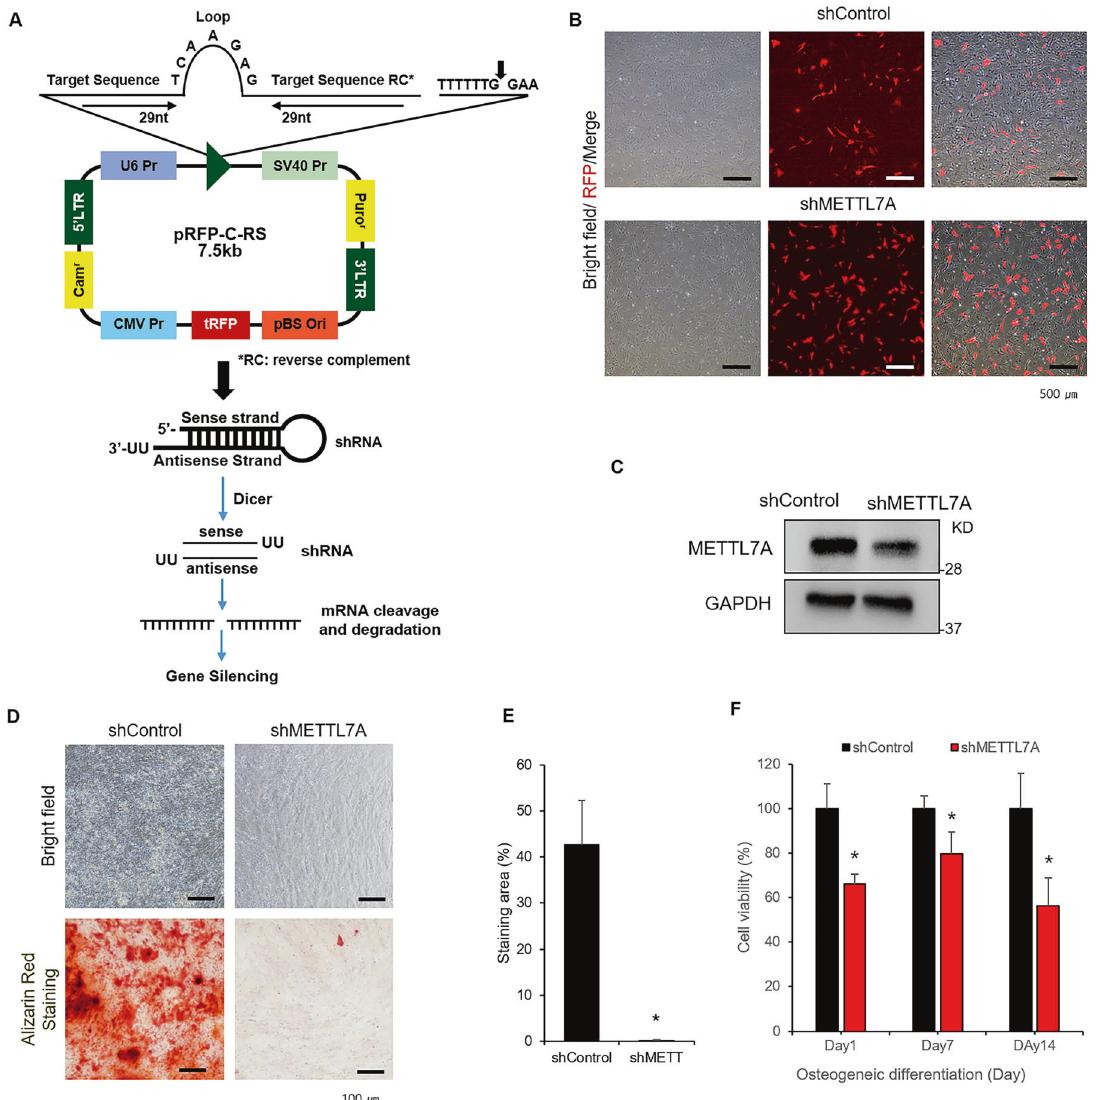
Fig. 3 The effect of METTL7A knockdown on cell viability and osteogenic differentiation of hBMSC. A Construction of shMETTL7A and scramble control vector. Each vector contains RFP fl uorescent genes. B Fluorescent, bright- fi eld and merge images of scramble control vector- and shMETTL7A-transfected hBMSCs (RFP-tagged) after 1 day of transfection. C Western blot of METTL7A in scramble control vector- (shControl) and shMETTL7A-transfected hBMSCs (shMETTL7A). D Alizarin Red staining images and E quanti fi cation of shControl and shMETTL7A in osteogenic medium containing 5.5 mM glucose after 14 days. F Cell viability of shControl and shMETTL7A cultured under osteogenic medium containing 5.5 mM glucose on days 7, 14, and 21. Data were presented as mean ± standard deviation (SD, N = 3). NS: no signi fi cant difference, * p < 0.05, ** p < 0.01. shControl: control vector-transfected hBMSCs; shMETTL7A:shMETTL7A-transfected length ” by the size of “ bin ” con fi rms the number of bins to MicroCT imaging (Fig. 5C). The bone mass (BV, mm 3 ), BV/TV (bone calculate the per-base value of each region. The average of bins mass/total volume, %) and bone mineral density (BMD) were re- for each region was determined and the heatmap was created by evaluated by MicroCT. BV and BV/TV of METTL7A group was about > stacking them vertically. The heat maps are represented by 2-fold higher than that of the MC group. BMD of METTL7A group was transcription start site (TSS) and transcription end site (TES). The similar to that of normal bone, and also signi fi cantly greater than that corresponding formula for each of the three comparative pairs of MC group (Fig. 5D). Histological fi ndings also demonstrated that was determined according to the scatter plot of the β -value of the METTL7A group had much better quality of bone regeneration DNA methylation sites in the three pairs of cells. Curve fi tting than in MC group or control group (Fig. 5E). These results indicated showed consistent DNA methylation pro fi les of hBMSCs under the that METTL7A overexpression enhances the in vivo regenerative three conditions. The methylation level in general was signi fi cantly potential of hBMSCs in bone healing. higher in G( + )OM than in G(-)OM (Fig. 6A). A osteogenesis-related gene peak heatmap using MeV 4.9.0 was generated to visualize DNA methylation pro fi les differed signi fi cantly in hBMSCs genes with relative differences in methylation between G( + )OM depending on glucose availability and G( − )OM, which showed signi fi cant differences in promotor DNA methylation pro fi les of G( + )CM, G( + )OM, and G( − )OM were methylation status of osteogenesis-related genes. Methylation of investigated using deepTools 3.3.0. Dividing the “ gene body